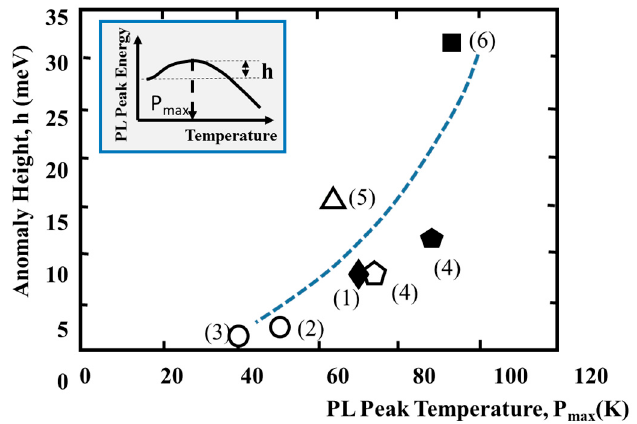
Figure 5. Relationship between anomalous height and PL peak temperature: ( 1 ) Ex145-B; ( 2 ) Ex145-A; ( 3 ) Ex146; ( 4 ) Ishitani et al. [42]; ( 5 ) Yanagisawa et al. [46]; and ( 6 ) Kondow et al. [43]. Solid symbols; Ordered structure, Circular symbols; Disordered + Ordered structure.